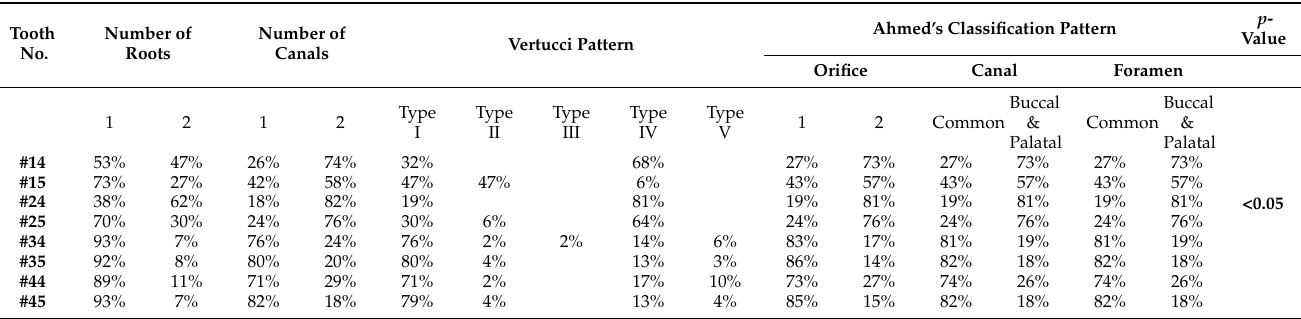
Table 1. Comparison of roots and canal configuration in according to Vertucci and Ahmed’s classifi-